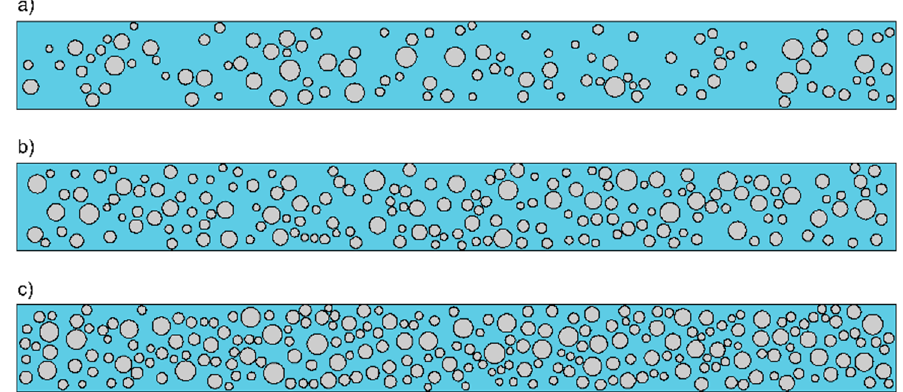
Figure 6. Geometry of numerical models varying in aggregate ratio: ( a ) Model A1, ( b ) model A2, and ( c ) model A3.